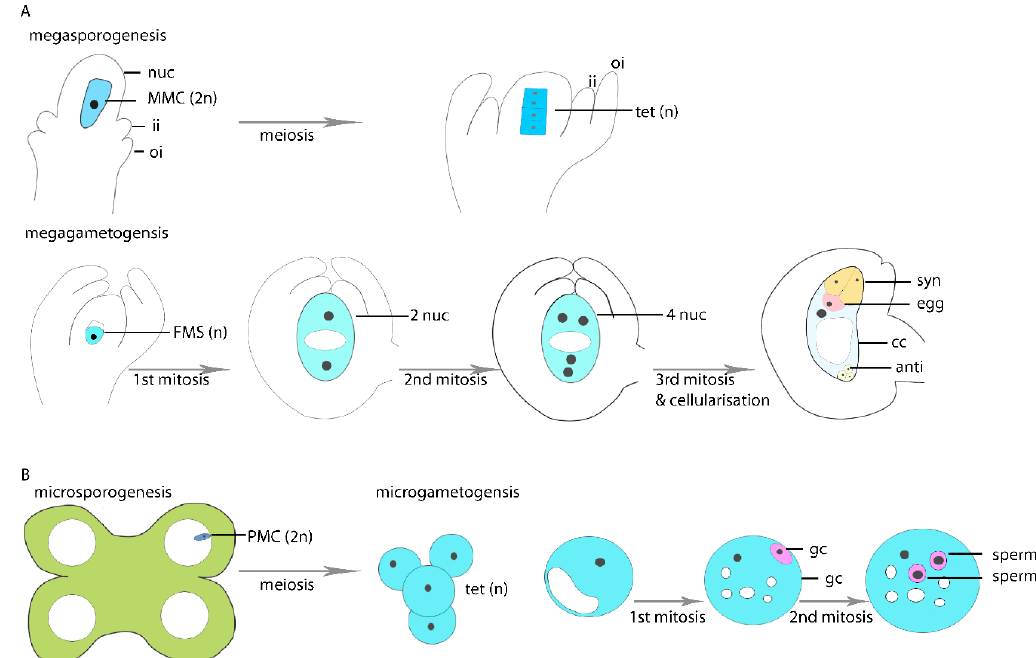
Figure 1. Development of the female ( A ) and male ( B ) reproductive lineages in sexual higher plants. ( A ) Formation of the female reproductive lineage initiates with the selection of a single diploid sporophytic cell in the nucellus (nuc) tissue of the ovule. This cell specifies as megaspore mother cell (MMC). Before meiosis of the MMC, the inner- and outer integuments of the ovule (ii and oi, respectively) are starting to grow. The MMC undergoes meiosis to give rise to a tetrad (tet) of haploid megaspores. Dependent on their position in the nucellus, three of the megaspores undergo apoptosis. Only the surviving functional megaspore (FMS) initiates gametogenesis. It undergoes three rounds of mitoses and cellularization to form the mature gametophyte harboring the two synergids (syn), the egg cell (egg), central cell (cc) and the antipodals (anti). ( B ) Formation of the male reproductive lineage initiates with selection of a single sporophytic cell, which is the pollen mother cell (PMC) that is committed to meiosis. Each of the four microspores of the tetrad (tet) survives and develops into a mature pollen by two mitotic divisions. During pollen mitosis I a generative cell (gc) engulfed in the vegetative cell (vc) is formed. During pollen mitosis II the generative cell divides to give rise to two haploid sperm cells.